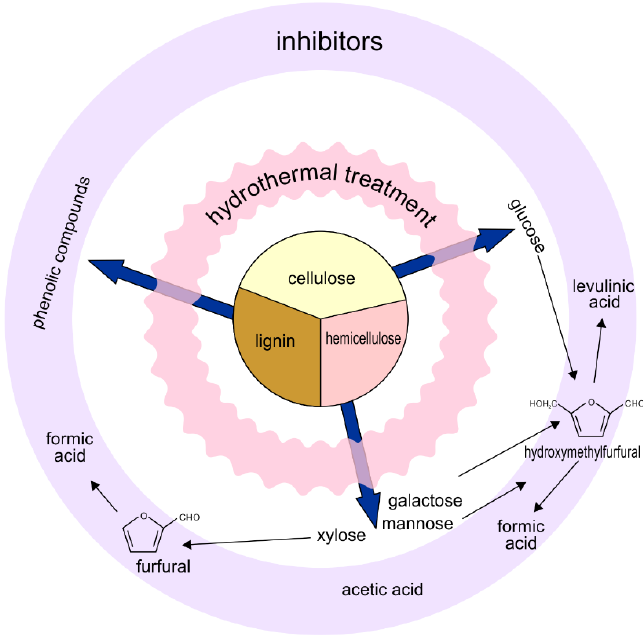
Figure 1. Schematic representation of the hydrolysis and decomposition of biomass during the hydrothermal treatments.